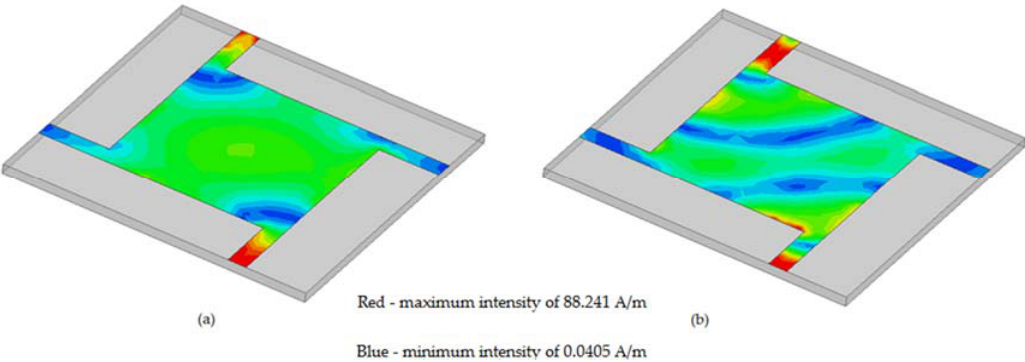
Figure 6. Current distribution of Square Patch Crossover: ( a ) at 2.43 GHz; ( b ) at 5.2 GHz.